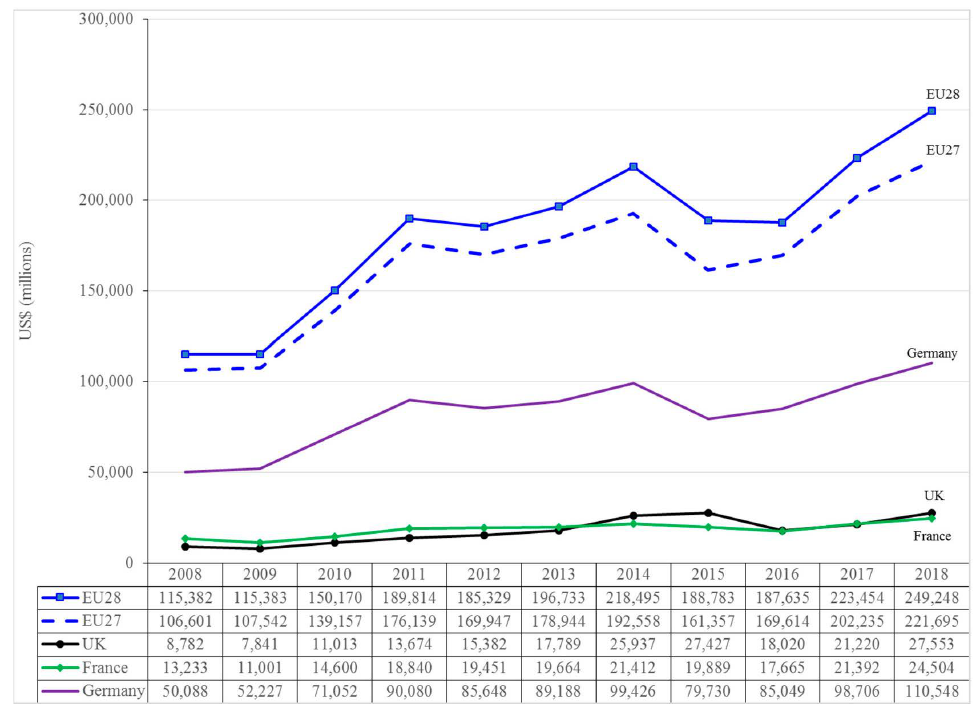
Goods exports to China (US$ [millions]), 2008–20. Source: International Monetary Fund, ‘Direction of Trade Statistics’ (2020) <http://data.imf.org/?sk=9D6028D4-F14A-464C-A2F2-59B2CD424B85> accessed